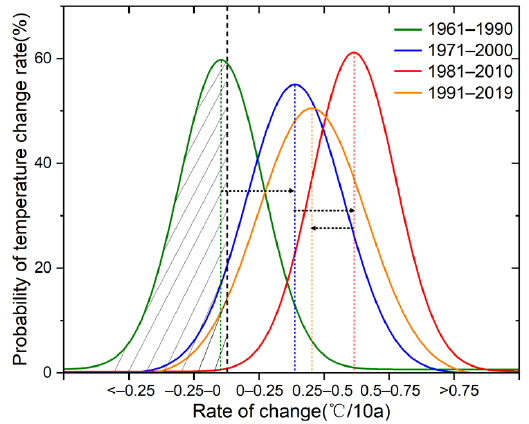
Figure 6. Probability distribution of annual temperature change rate in different periods.